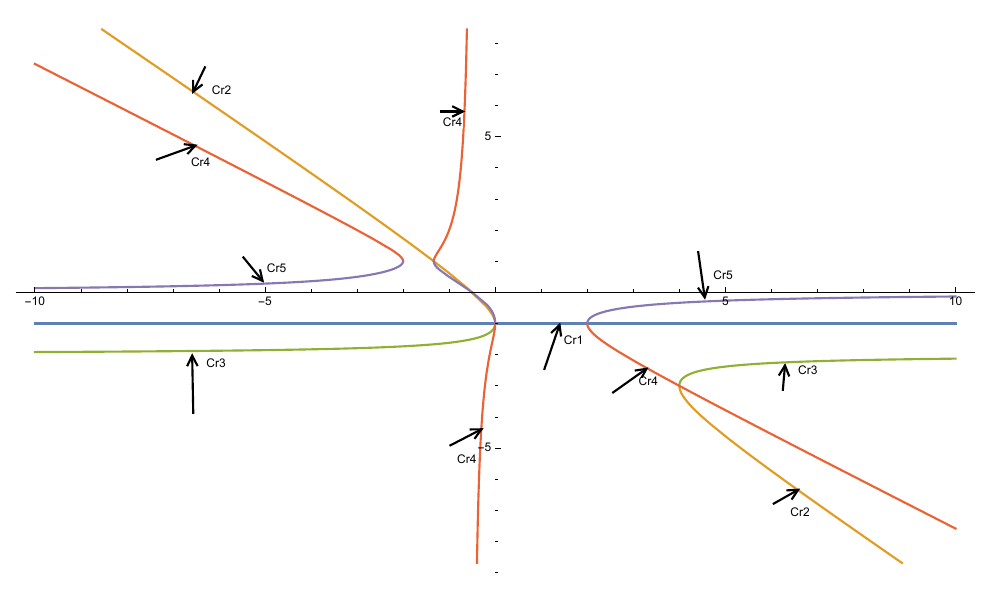
Figure 3. Bifurcation diagram of critical